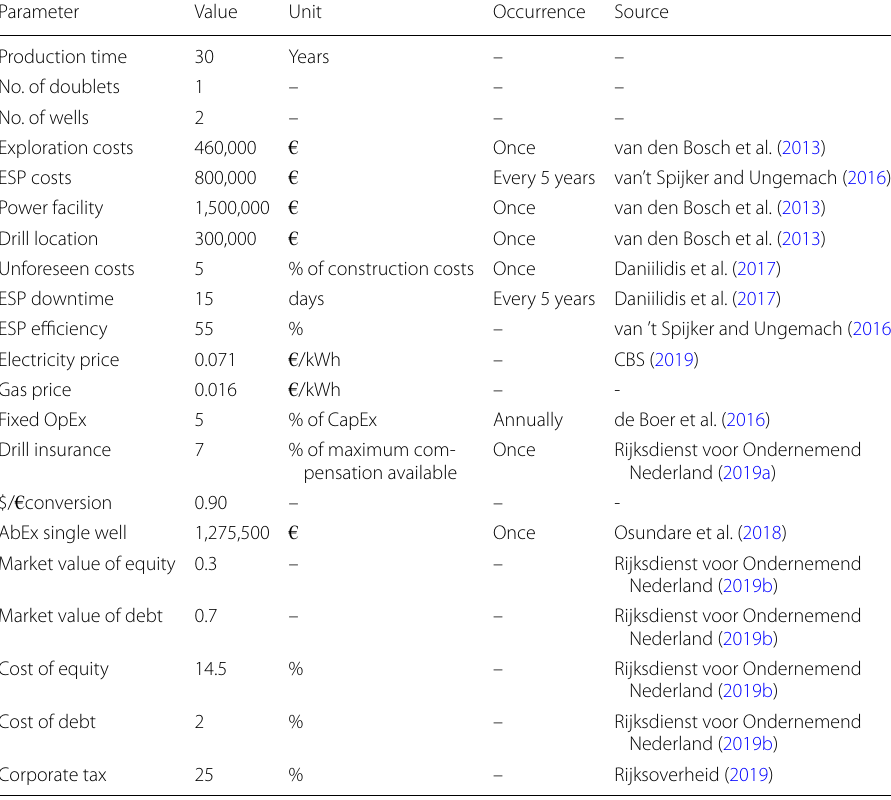
Table 4 Economic model